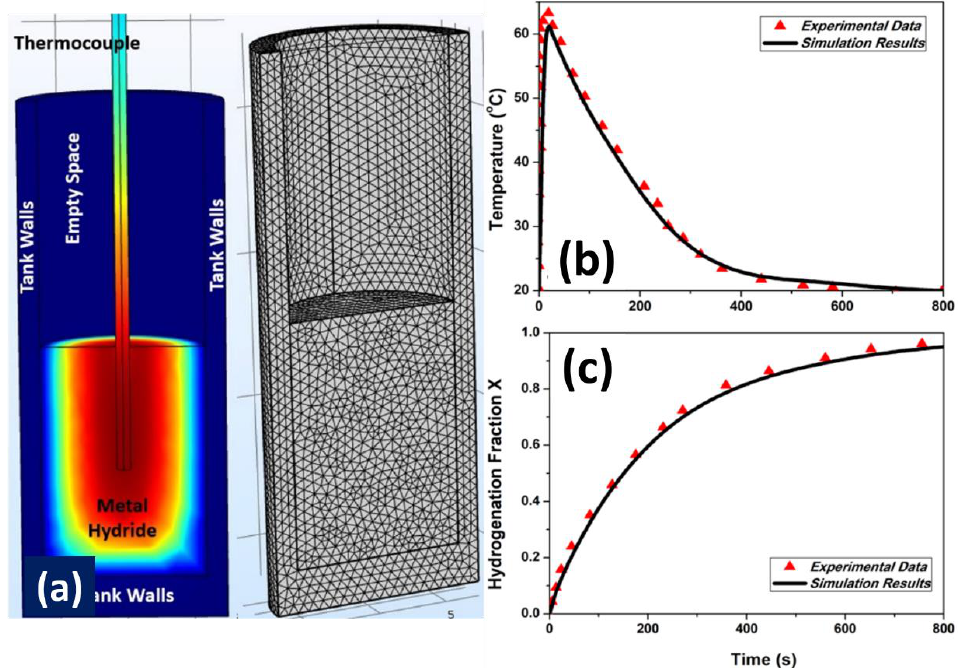
Figure 2. Geometry used for the validation ( a ); ( b , c ) present the temperature and hydrogenation profile of the numerical data against the experimental data. profile of the numerical data against the experimental